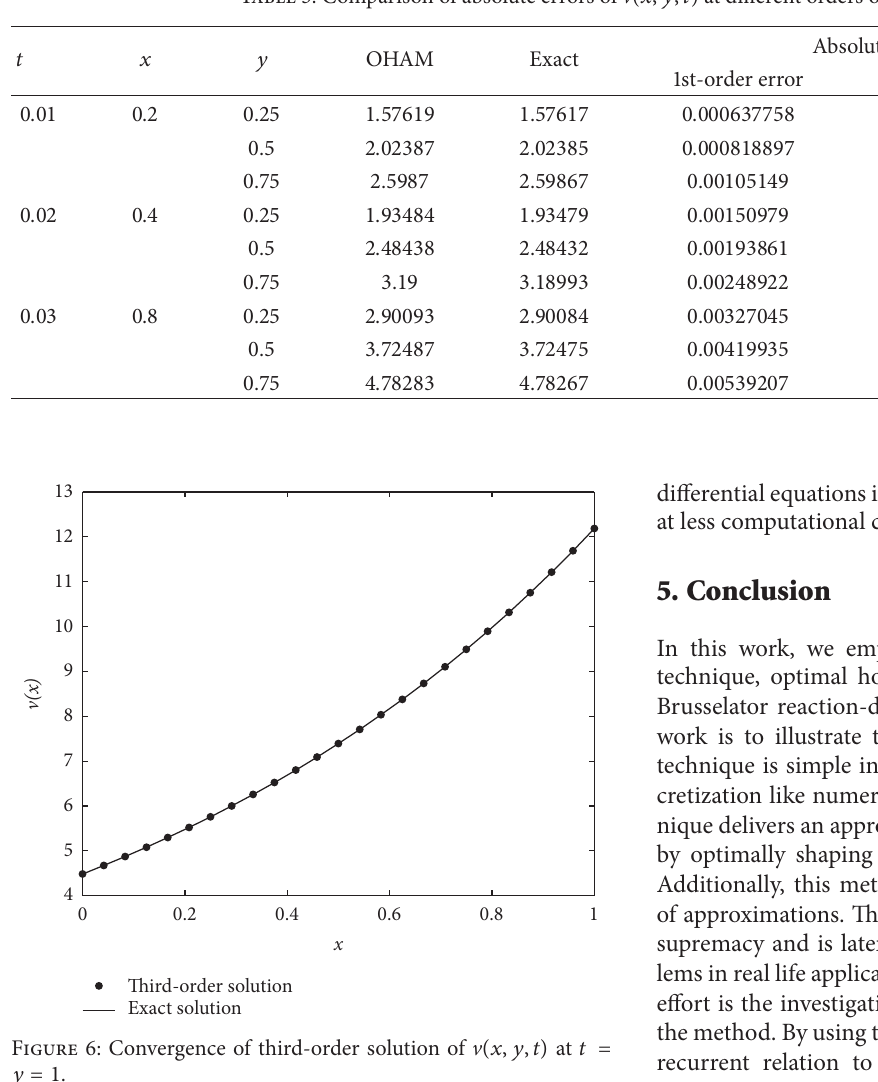
Table 3: Comparison of absolute errors of V (𝑥,𝑦, 𝑡) at different orders of approximation.